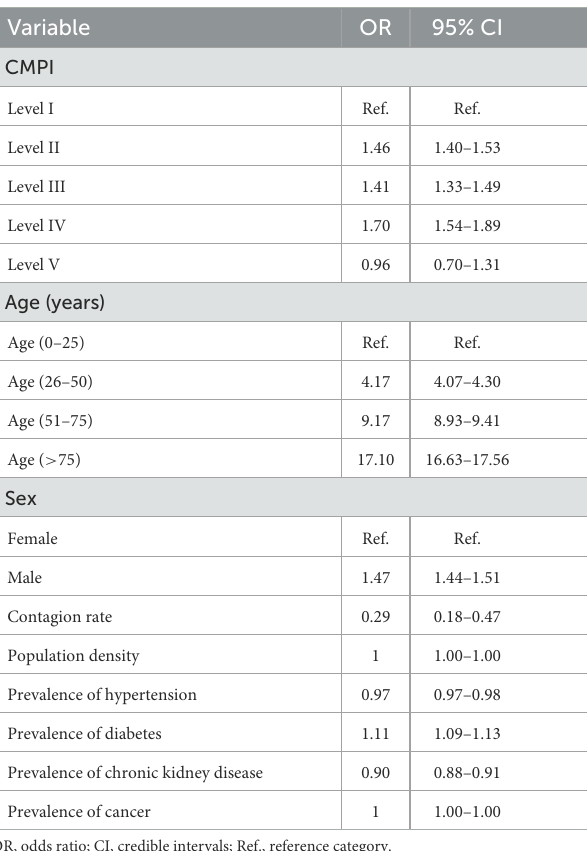
TABLE 2 Adjusted associations between multidimensional poverty measures and mortality from COVID-19 in hospitalized patients, adjusted for different